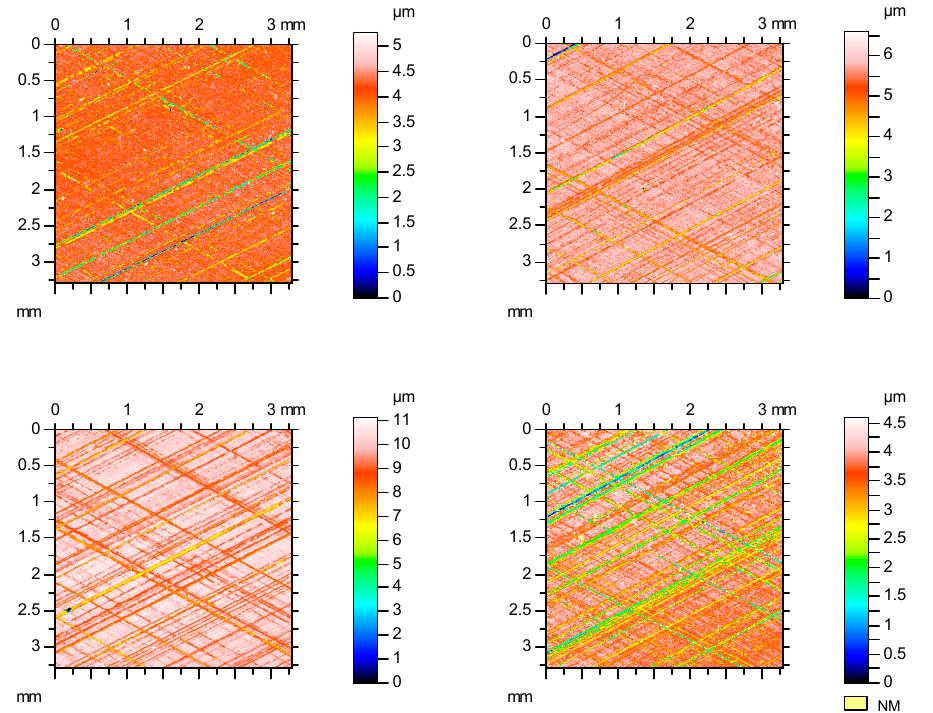
Figure 4. Contour plots of the plateau-honed cylinder surfaces.